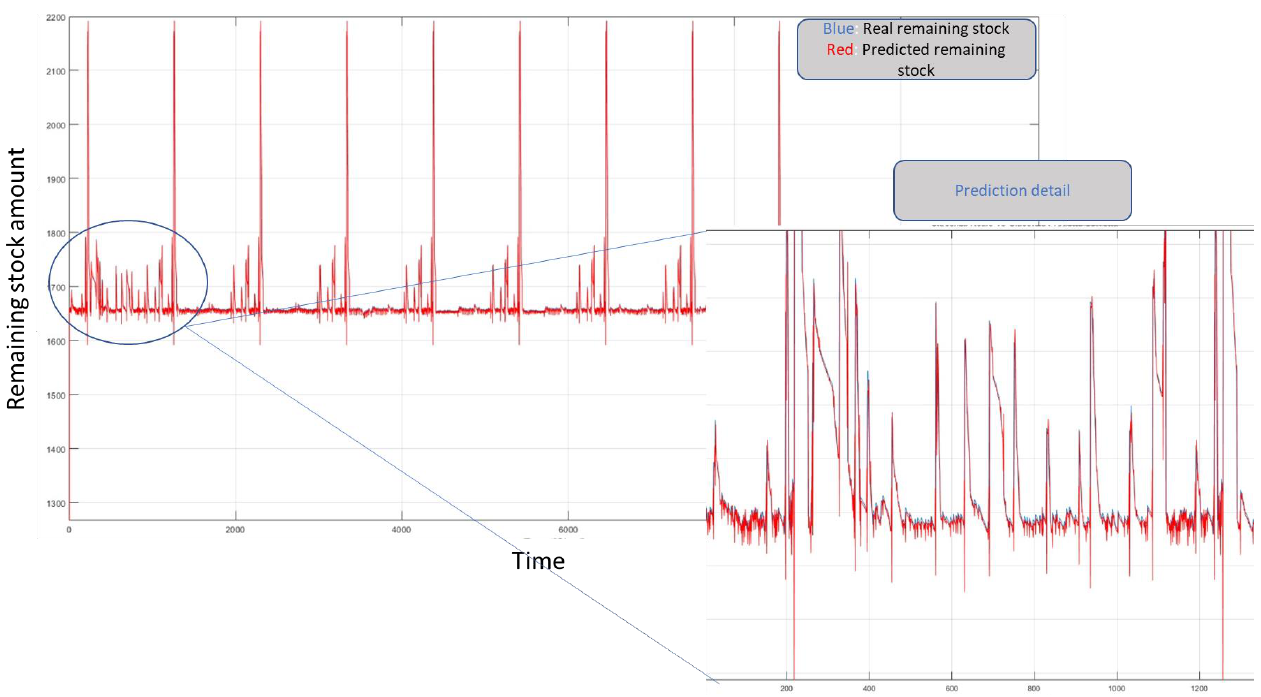
Figure 5. The benchmark comparison of the downstream intelligent regressor. (Blue): real dynamic of the product’s remaining stock; (red): predicted remaining stock of product .